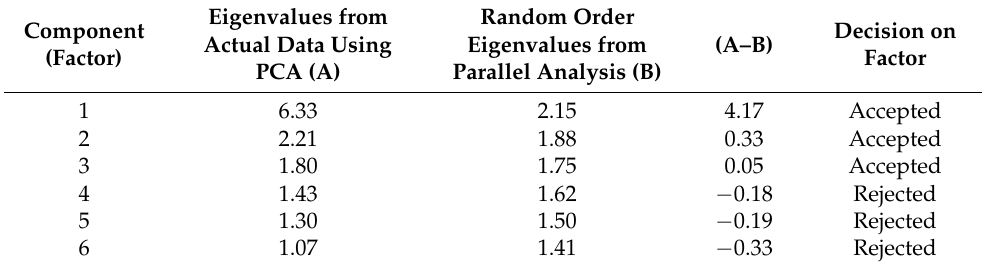
Table 7. Parallel analysis.